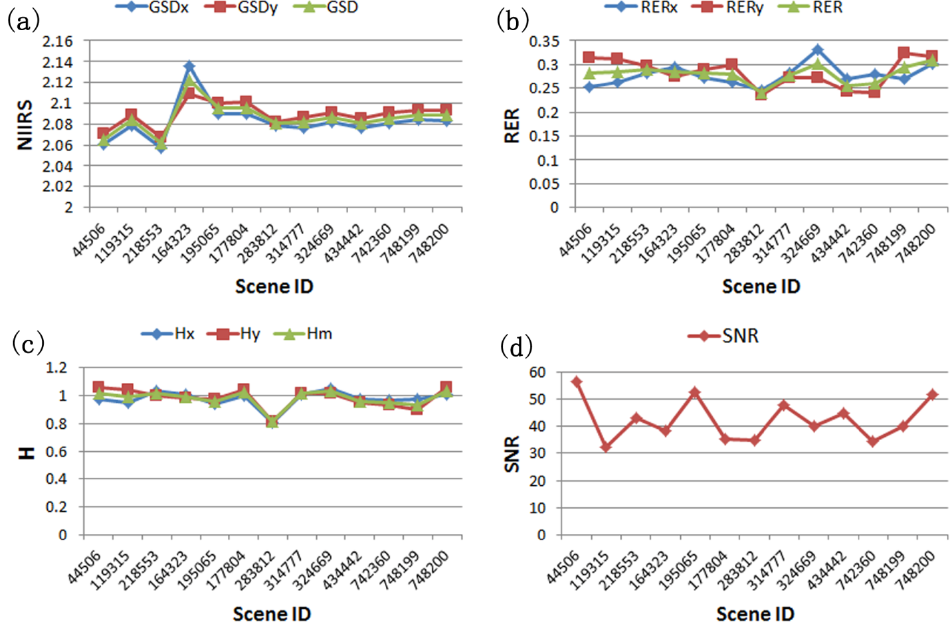
Figure 4. Results of the GIQE parameters. ( a ) The calculation results of GSD. ( b ) The chart of the results of RER. ( c ) The values of H. ( d ) The results of